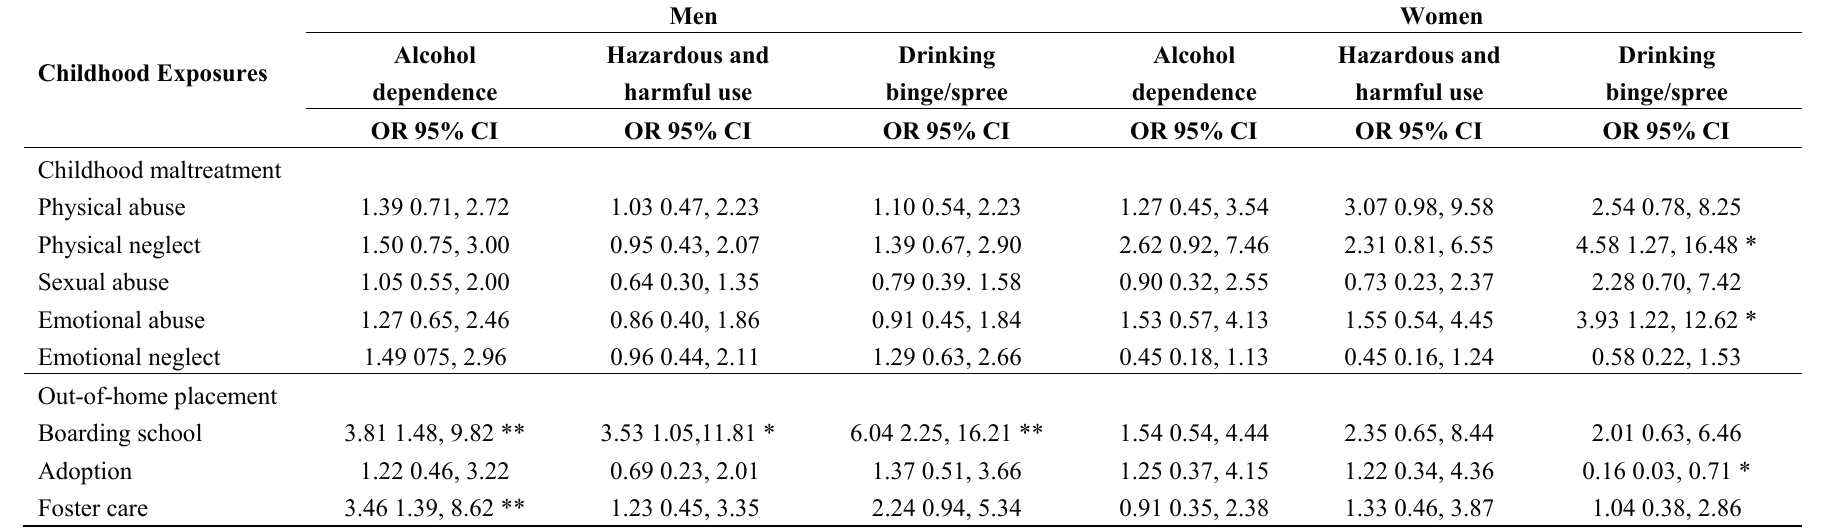
Table 4. Percentages of number of childhood exposures and adjusted odds ratios (OR) of past-year alcohol dependence. Men Women Total Number of Exposures N (%) N